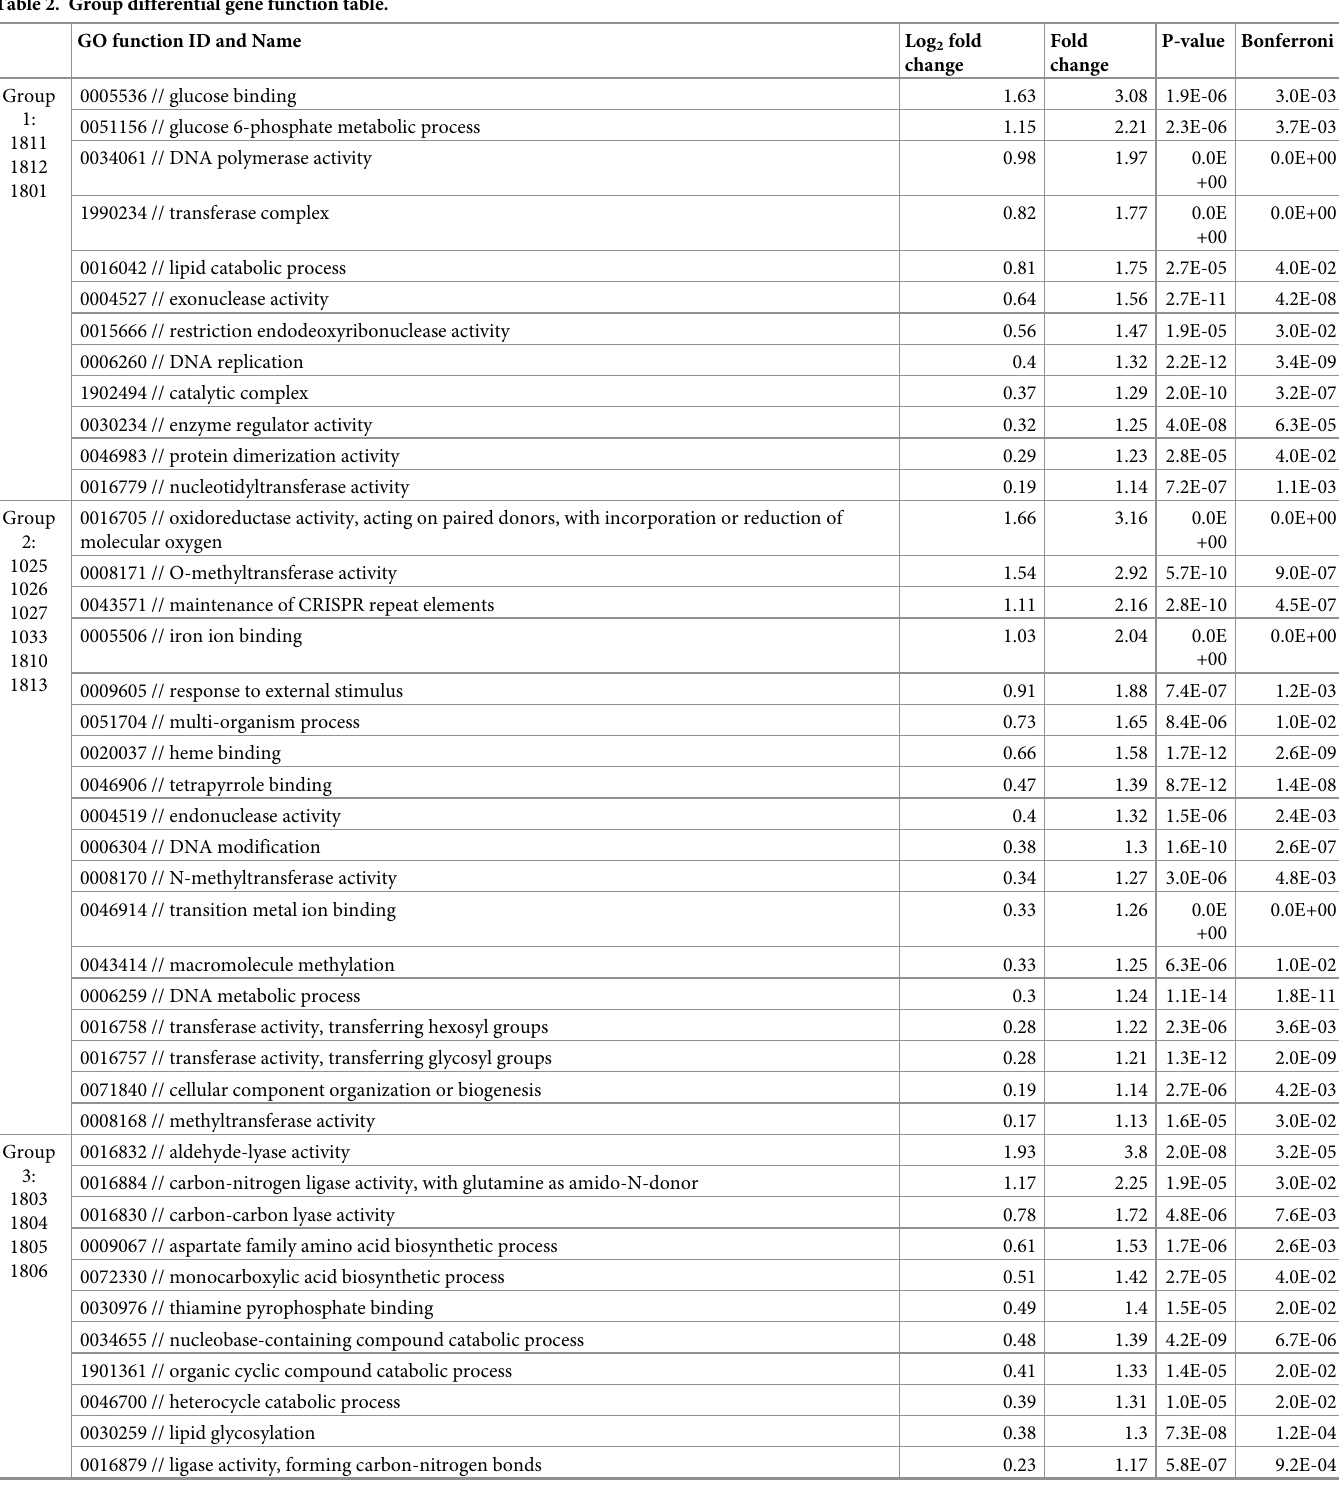
Table 2. Group differential gene function